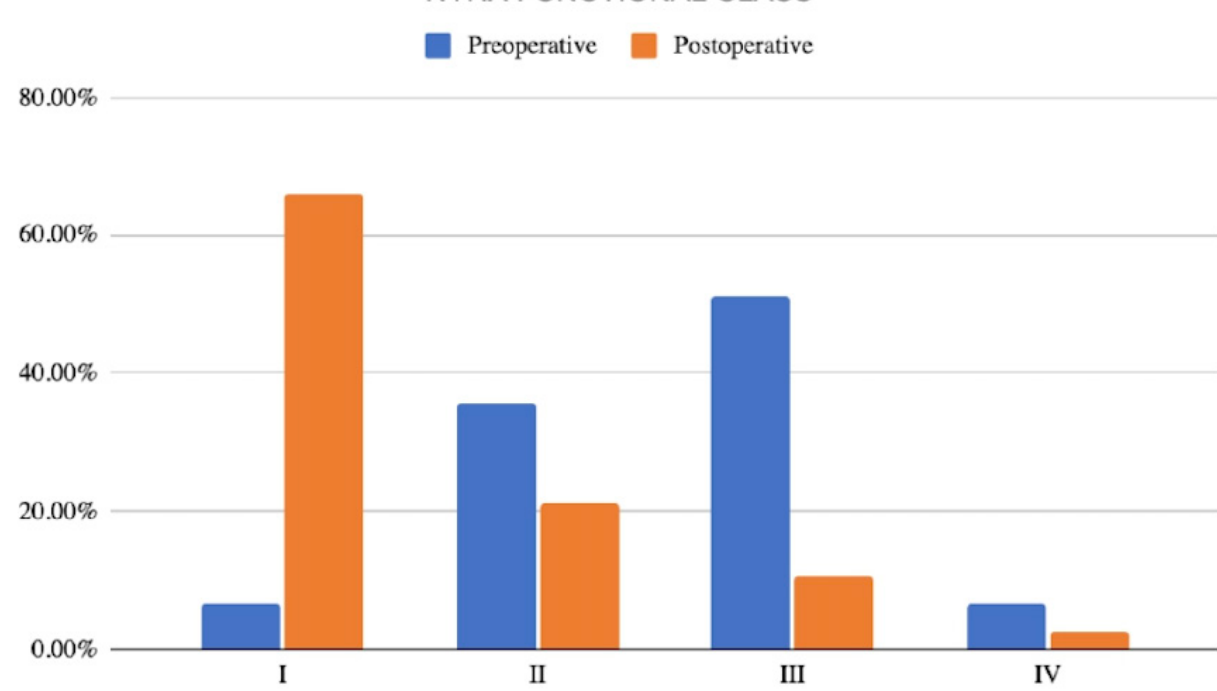
Fig. 2 - Comparison of preoperative and postoperative functional class. NYHA=New York Heart